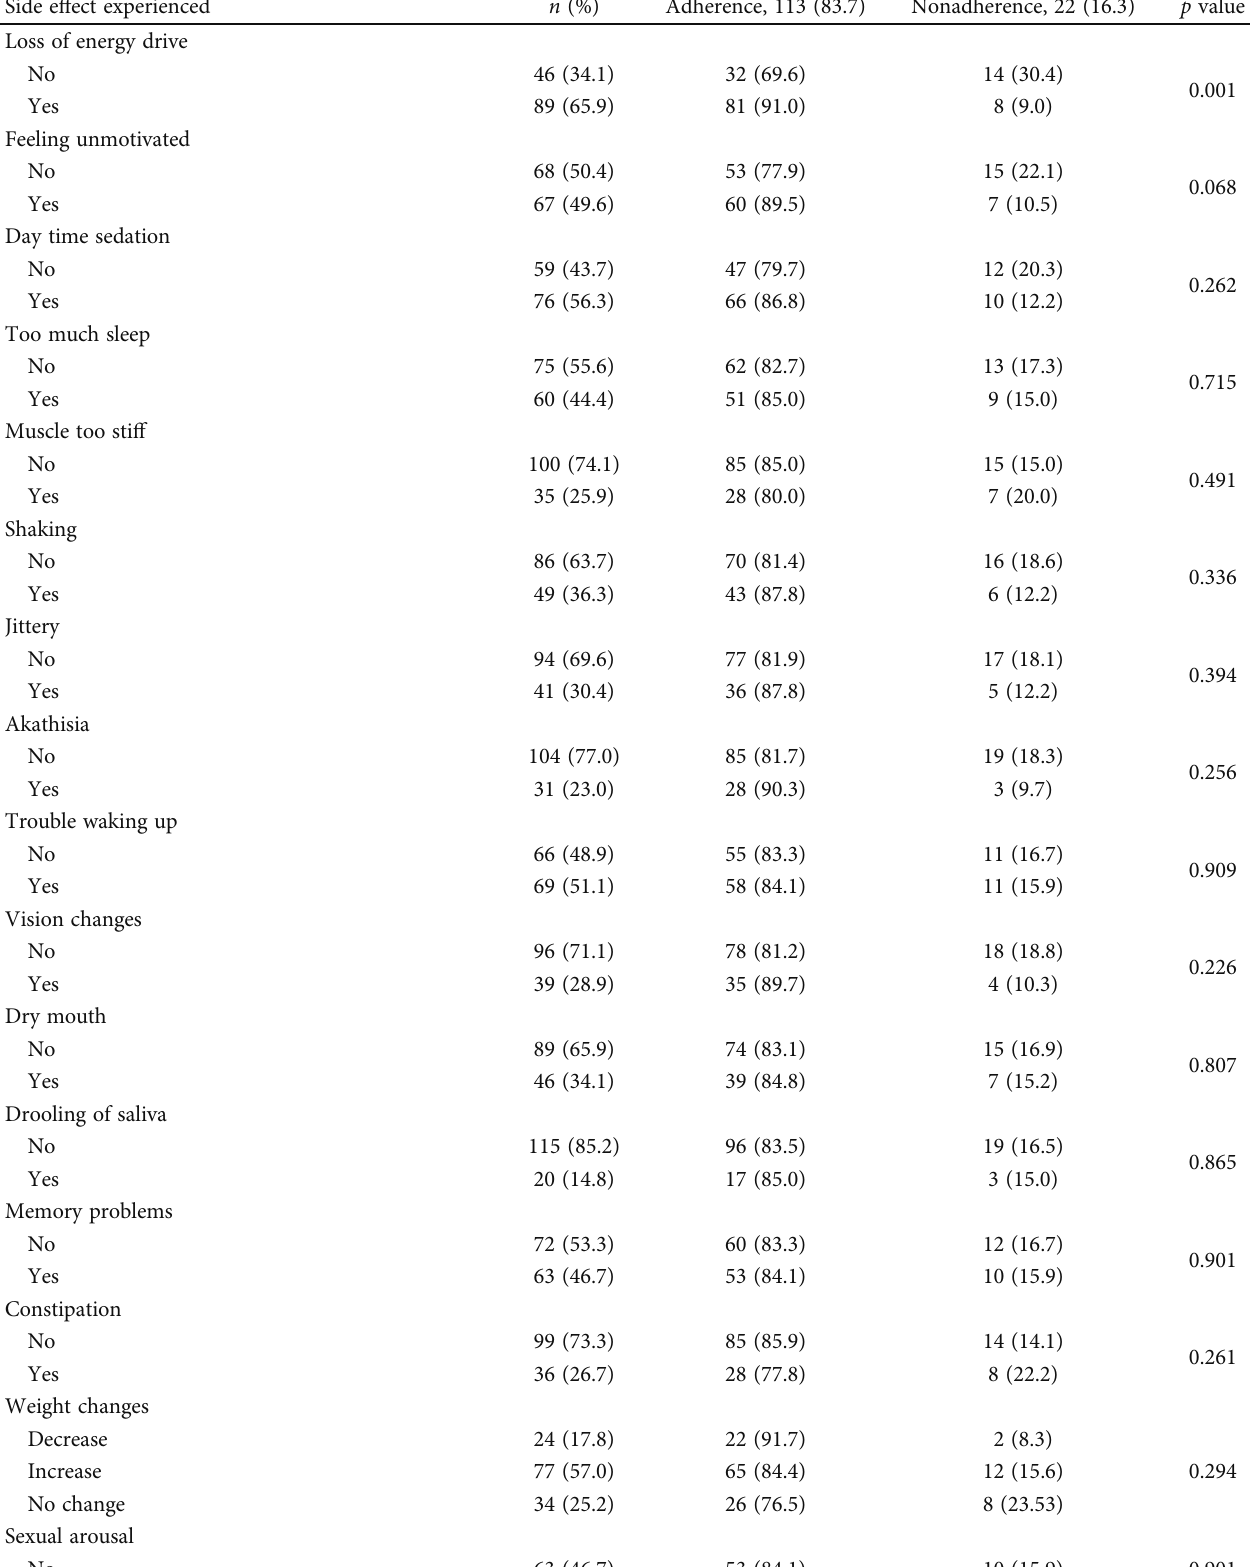
Table 4: Relationship between adherence status and side e ff ects